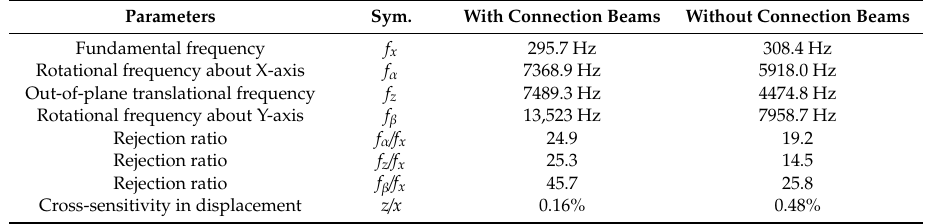
Table 2. Simulation results of the suspension systems with and without the connection